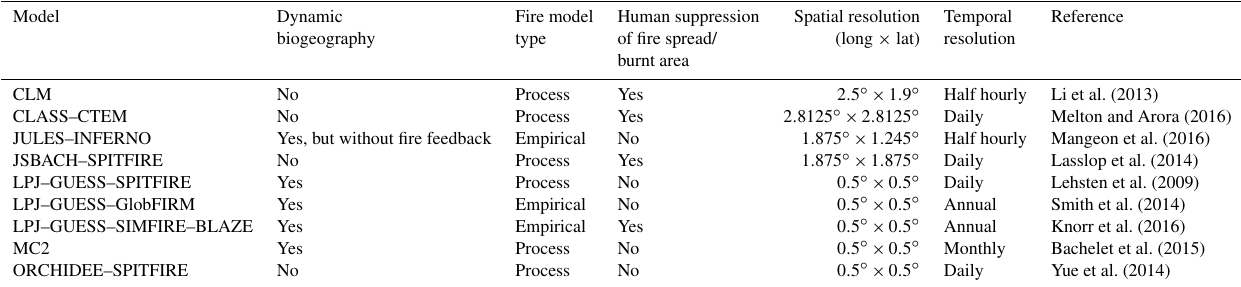
Table 1. Brief description of the global fire models that ran the FireMIP baseline experiments. Process indicates models which explicitly simulate ignitions and fire spread. A detailed overview can be found in Rabin et al.